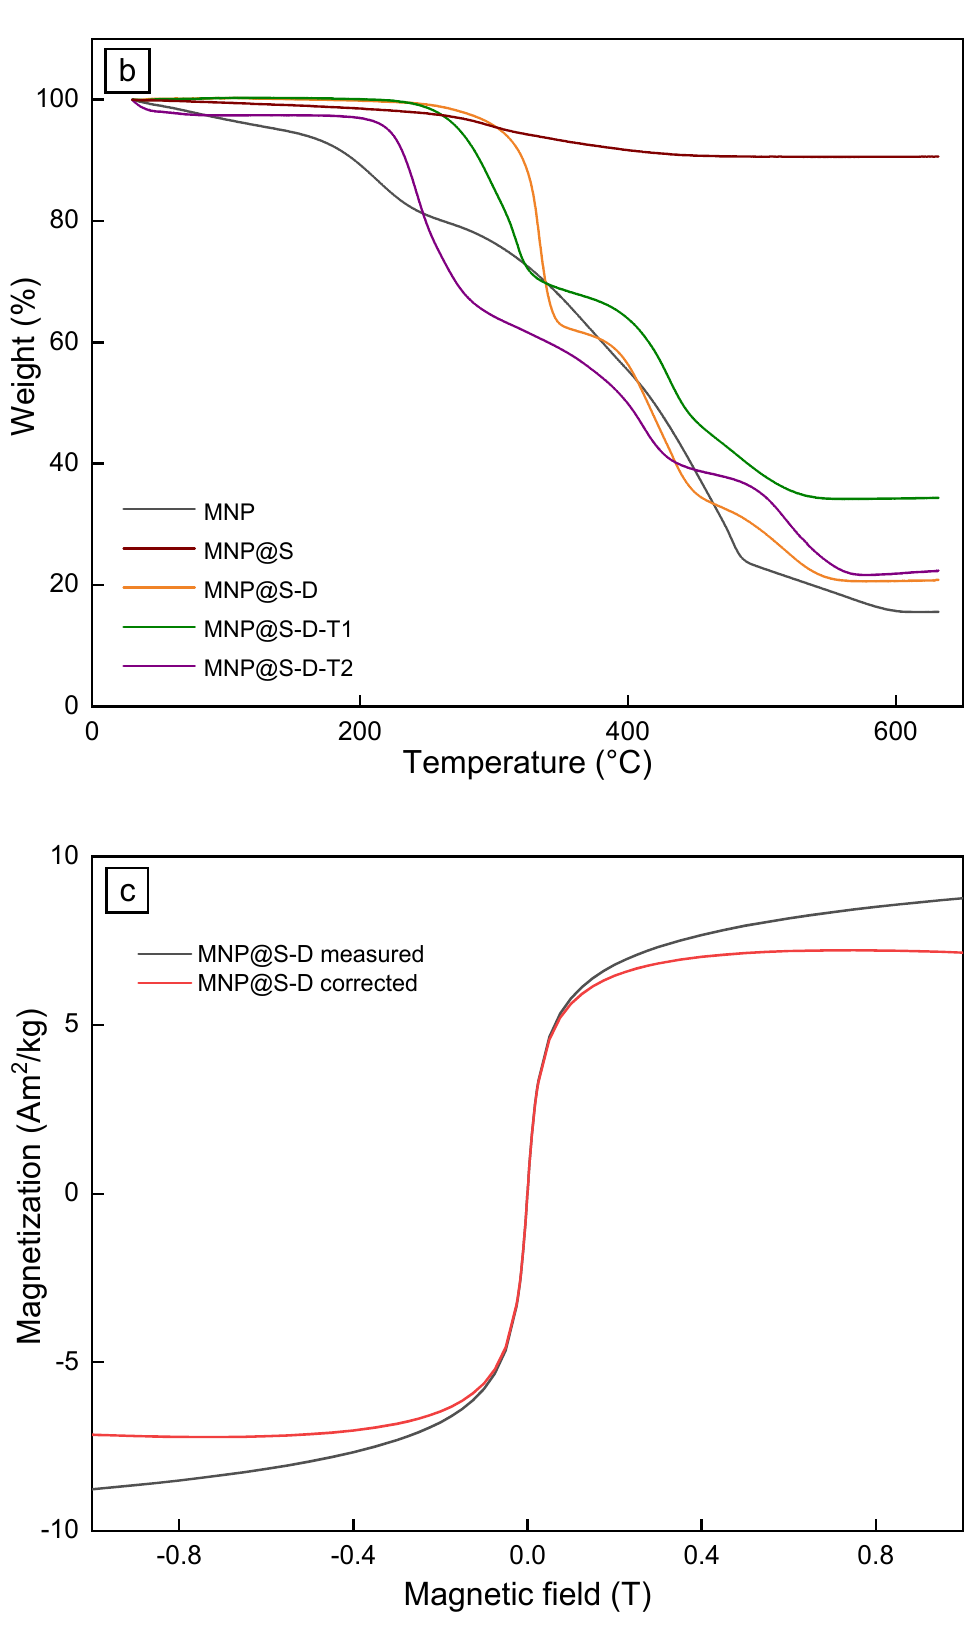
Figure 3. ( a ) FTIR and ( b ) TGA spectra of OA, MNP, MNP@S-D, MNP@S-D-T1, and MNP@S-D-T2. ( c ) Hysteresis loop of the MSP-S-D.